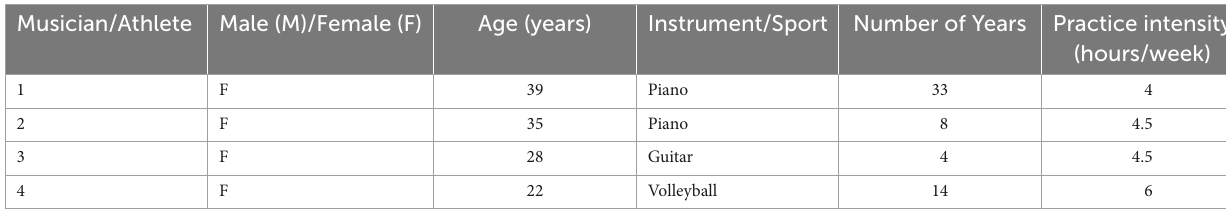
TABLE 1 Characteristics of